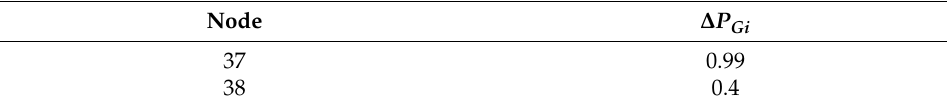
Table 9. Generator adjustment when wind-power output is